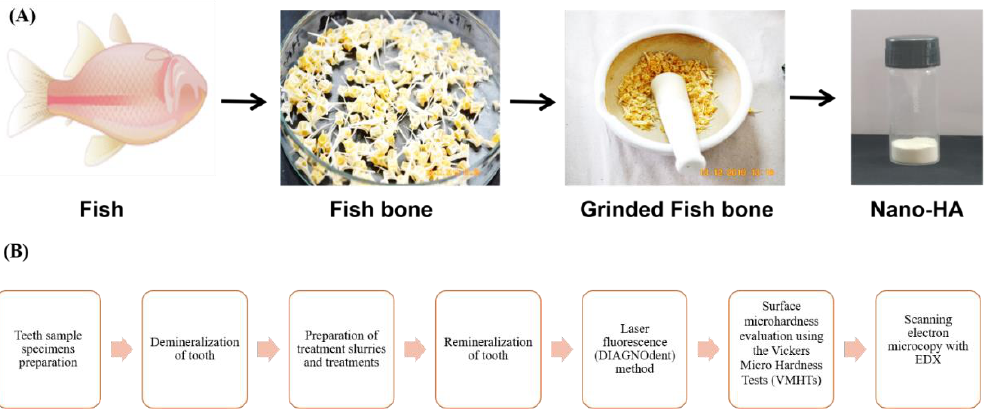
Figure 1. ( A ) Schematic diagram of the preparation of nano HA powder from the fishbone. The two different methodologies, thermal calcination and alkaline hydrolysis, were utilized to isolate HA from the fishbone, and ( B ) Summary of processes involved in demonstrating the remineralization potential of the isolated nano HA.